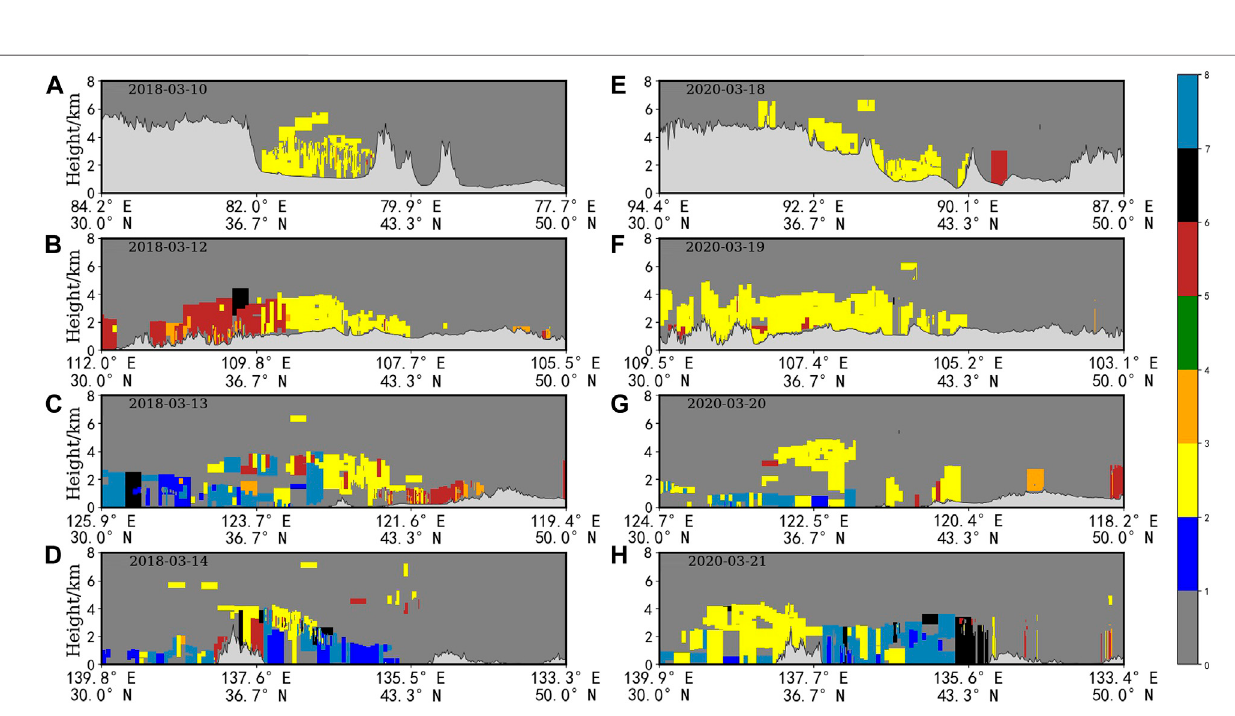
Frontiers in Environmental Science |